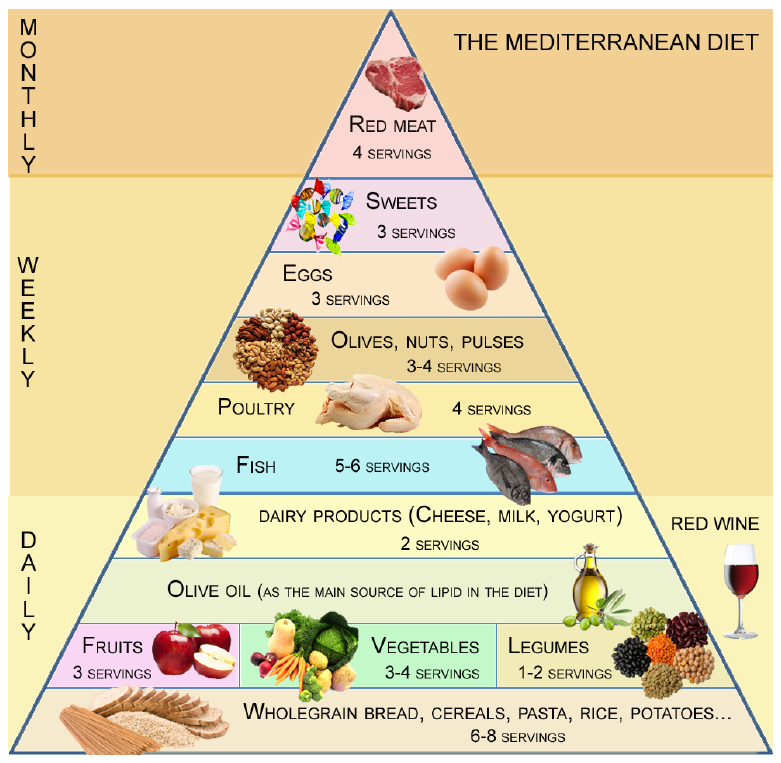
Figure 1. The Mediterranean diet food pyramid with servings.